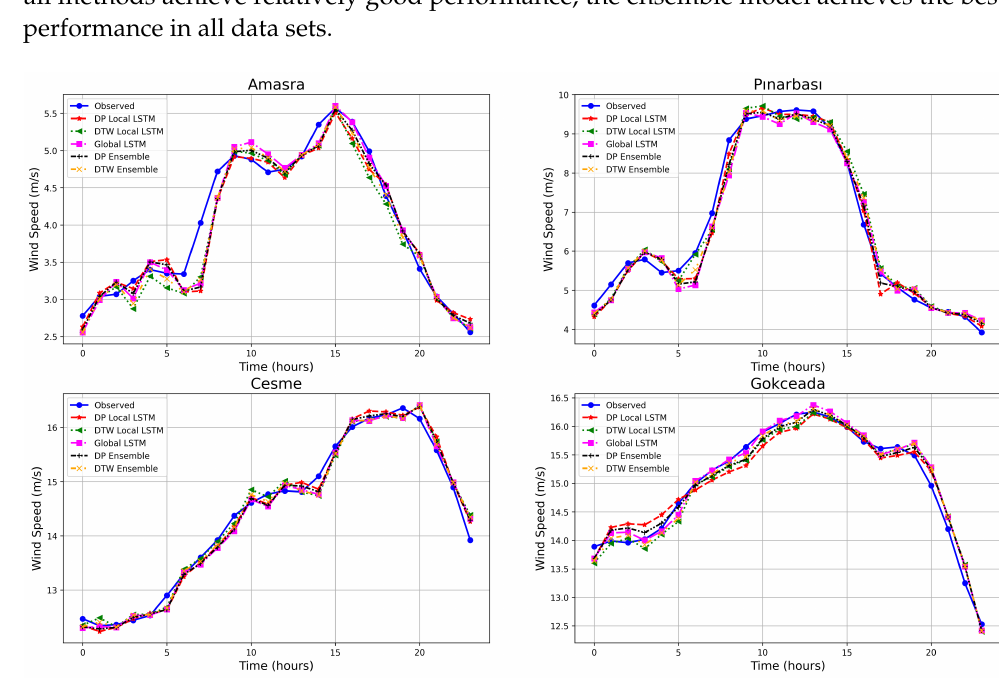
Figure 7. Actual and forecasted wind speed values for each method for 24 h time